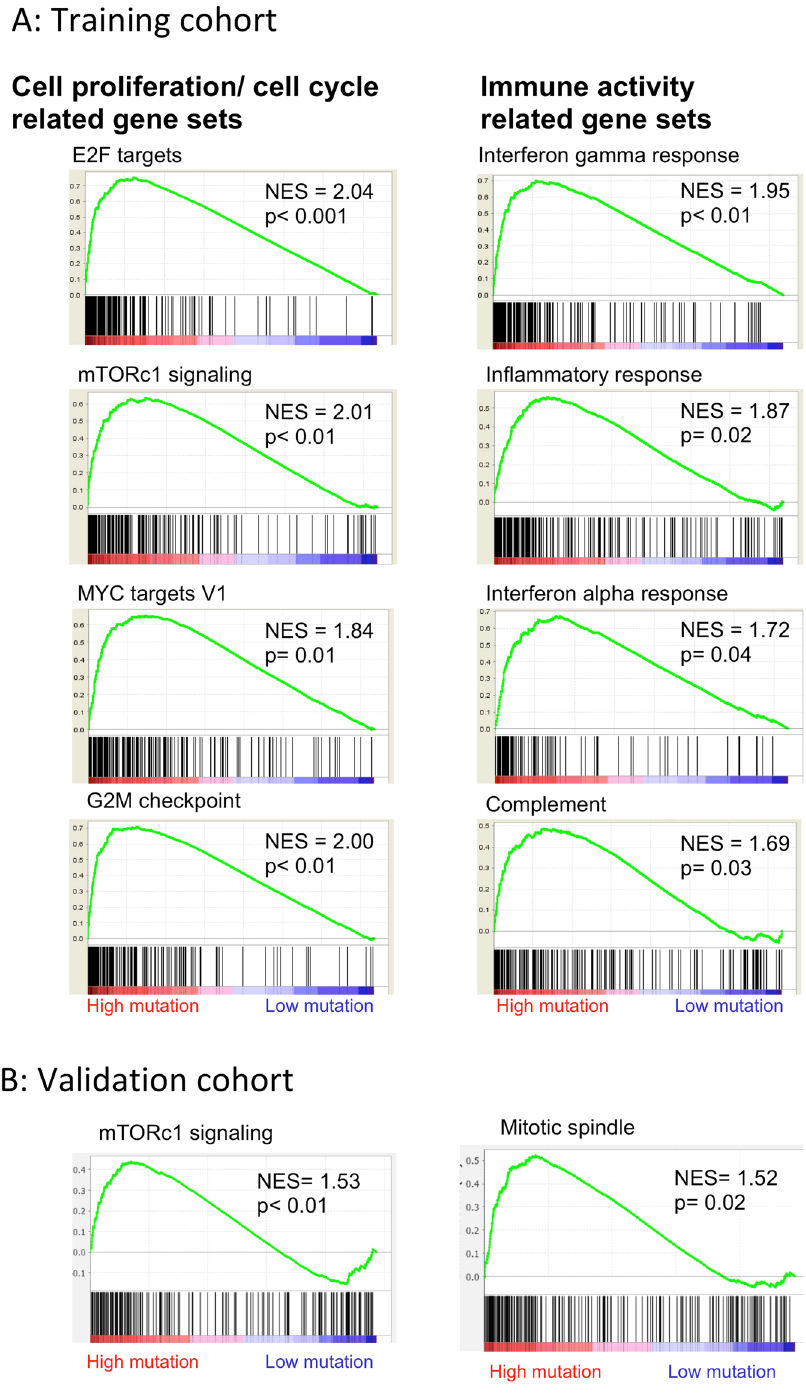
Figure 5. ( A ) Enrichment plots of tumors with high mutation rates by gene sets enrichment analysis (GSEA) in the training cohort. Tumors with high mutation rates were associated with cell proliferation/ cell cycle related gene sets, such as E2F targets (NES = 2.04, p < 0.001), mTORc1 signaling (NES = 2.01, p < 0.01), MYC targets v1 (NES = 1.84, p = 0.01), and G2M checkpoint (NES = 2.00, p < 0.01). Furthermore, tumors with high mutation rates were associated with immune activity related gene sets, such as Interferon gamma response (NES = 1.95, p < 0.01), Inflammatory response (NES = 1.87, p = 0.02), Interferon alfa response (NES = 1.72, p = 0.04), and Complement (NES = 1.69, p = 0.03). ( B ) Enrichment plots of tumors with high mutation rates by gene sets enrichment analysis (GSEA) in the validation cohort. Tumors with high mutation rates were associated with only cell proliferation/ cell cycle related gene sets, mTORc1 signaling (NES = 1.53, p < 0.01), and Mitotic spindle (NES = 1.52, p = 0.02). NES, normalized enrichment